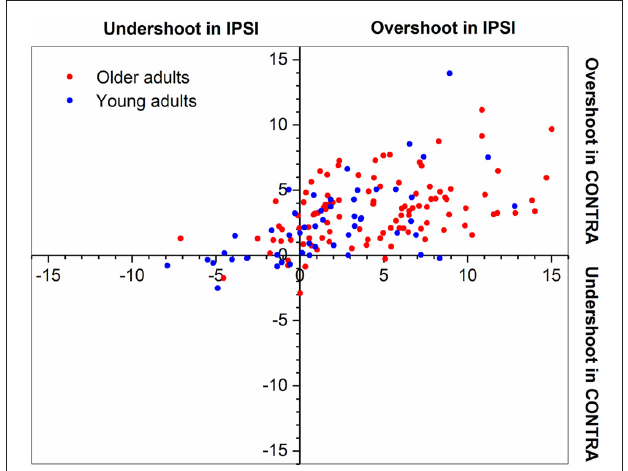
FIGURE 2 | Plot of overshoot/undershoot bias in older and young adults. Proprioceptive bias for both joint position matching tasks. Dots placed at the 0 ◦ position would indicate a perfect match. Note that both young and older adults tended to overestimate the 15 ◦ reference position. Each data point represents the mean of values for a single participant.